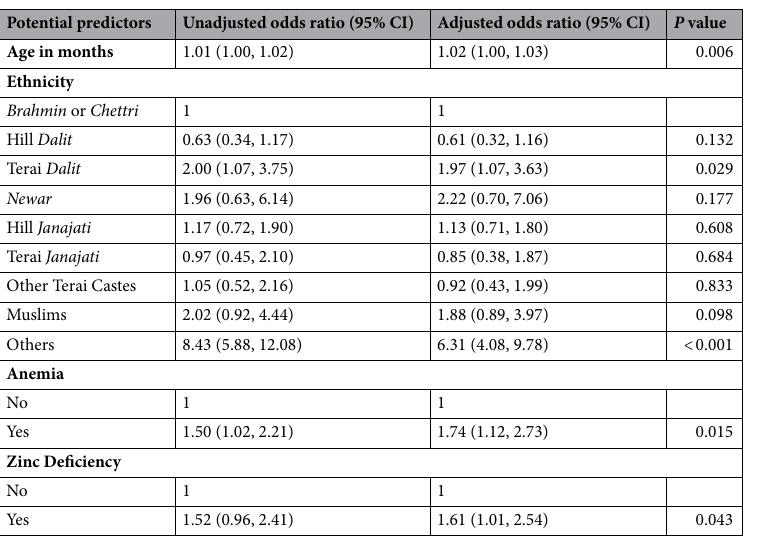
Table 3. Predictors of soil transmitted helminths among children aged 6–59 months, Nepal National Micronutrient Status Survey, Nepal, 2016. Estimates are unadjusted odds ratios and adjusted odds ratios with 95% confidence intervals from logistic regression models, accounting for weighting and complex sampling design. Anaemia was defined as altitude- and smoking- adjusted Hb < 12.0 g/dL 28 . g Zinc deficiency defined as serum zinc < 65.0 μg/dL for nonfasted, morning (i. e. before 12 pm) samples and < 57.0 μg/dL for non-fasted, afternoon (i. e. after 12 p.m.) samples, inflammation adjusted 28 .